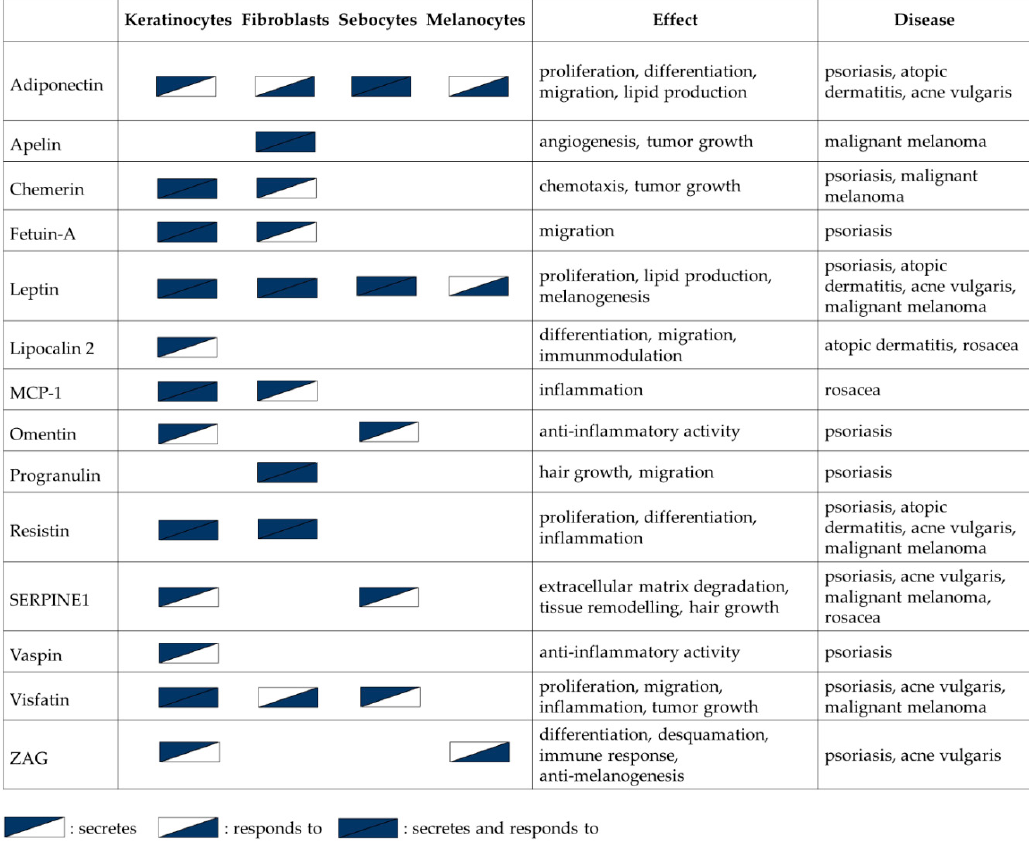
Figure 1. Overview of adipokines expressed and secreted by different human skin cell types and their effects on these cells.